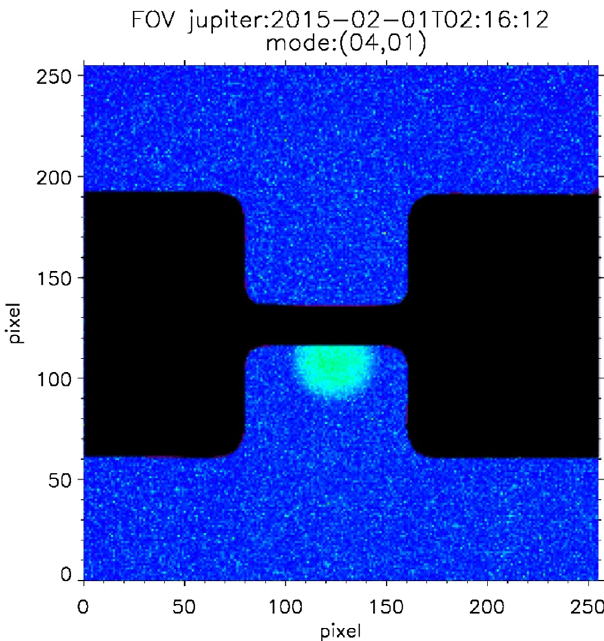
Fig. 8. Imaging data of FOV-L1 observed on 1 February, 2015. Horizontal and vertical axes show spatial locations in the detector coordinates (pixel). The horizontal and vertical axes roughly align with east-west and north-south directions of the ecliptic coordinates, respectively. Plate scale is 1.1 arcsec/pixel. Color shows arbitrary photon counts. Observation target was Jupiter, the shape of which is indicated in light green. The solid black region illustrates the expected location of the dumbbell-shaped slit of the EUV instrument, which is actually not seen in FOV data because the count rates of the sky background and dumbbell slit region are both at the noise level of the FOV detector. Integration time is 1